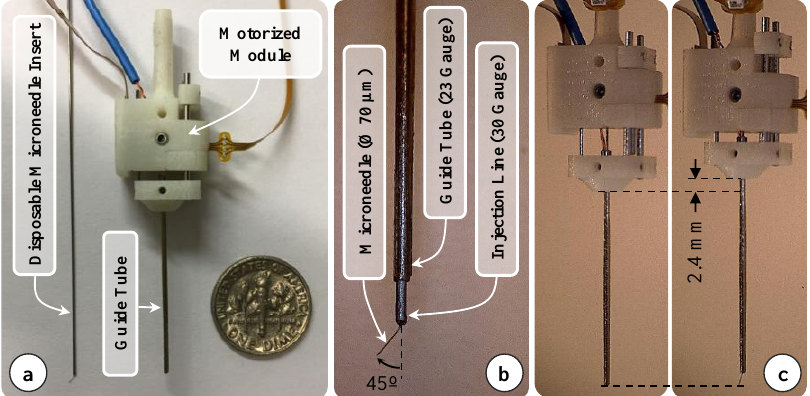
Figure 2. ( a ) Components of the design: force sensitive motorized unit, and the disposable prebent needle ( b ) Assembled prototype ( c ) Tool actuation: the microneedle is exposed by retracting the guide tube as much as 2.4 mm.